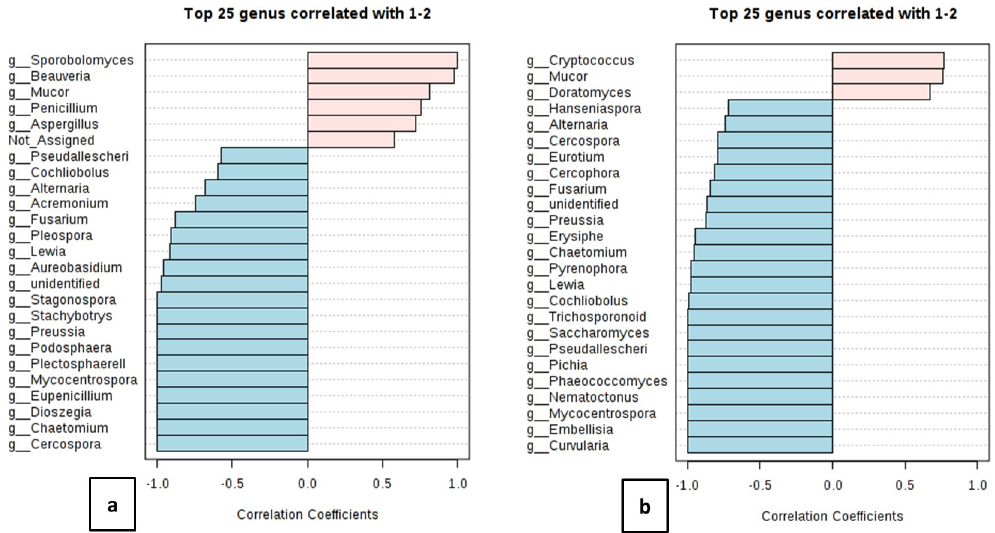
Fig 11. Correlation analysis of inhalable (a) A7-010718 and (b) K7-040418 fractions with their respirable counterparts. The top twenty five fungal genera with significant correlations coefficients are represented in the bar plots. 1 corresponds to inhalable whereas 2 corresponds to the respirable